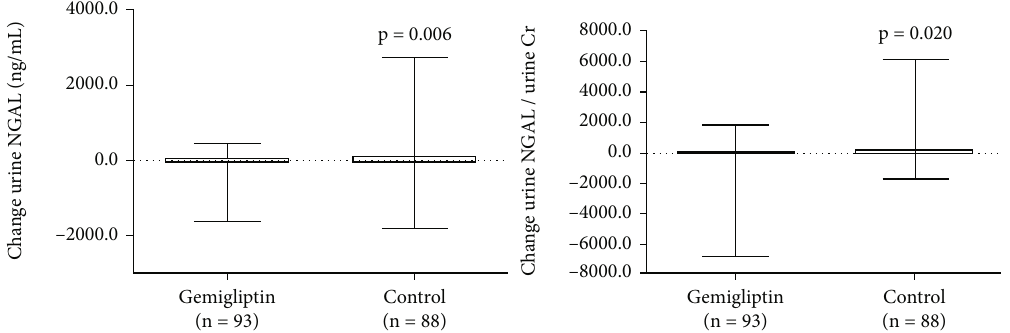
Figure 4: Comparisons between urine NGAL and urine NGAL factors for urine creatinine in both groups at baseline and at the end of the study.